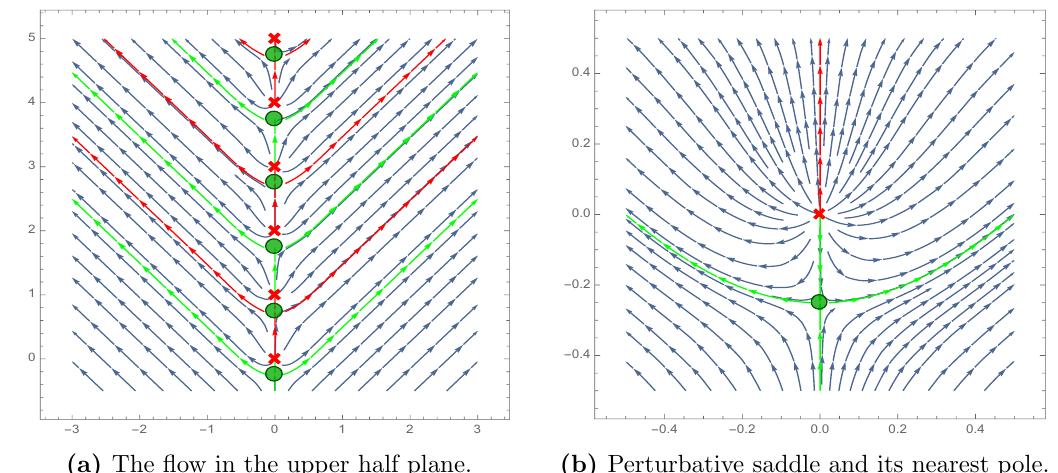
Figure 2. Morse (cid:13)ow for the theory with one chiral and one anti-chiral, b = 1, (cid:24) = 1. The green circles are saddle points while the red crosses are poles of the e(cid:11)ective action. From each saddle the downward (cid:13)ows (the J cycles) go o(cid:11) to 1 while the upward (cid:13)ows (K cycles) (cid:13)ow vertically until they hit a